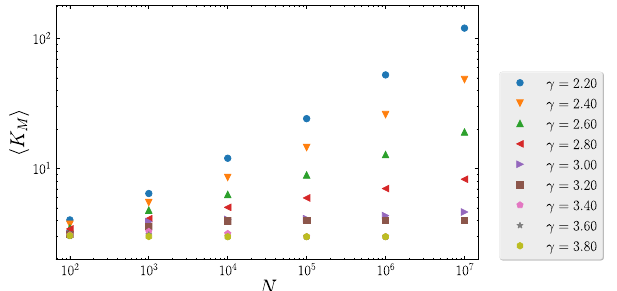
FIG. 11. Average maximum core index h K network size for reshuffled LPA networks with different degree exponent γ . Error bars are smaller than symbol